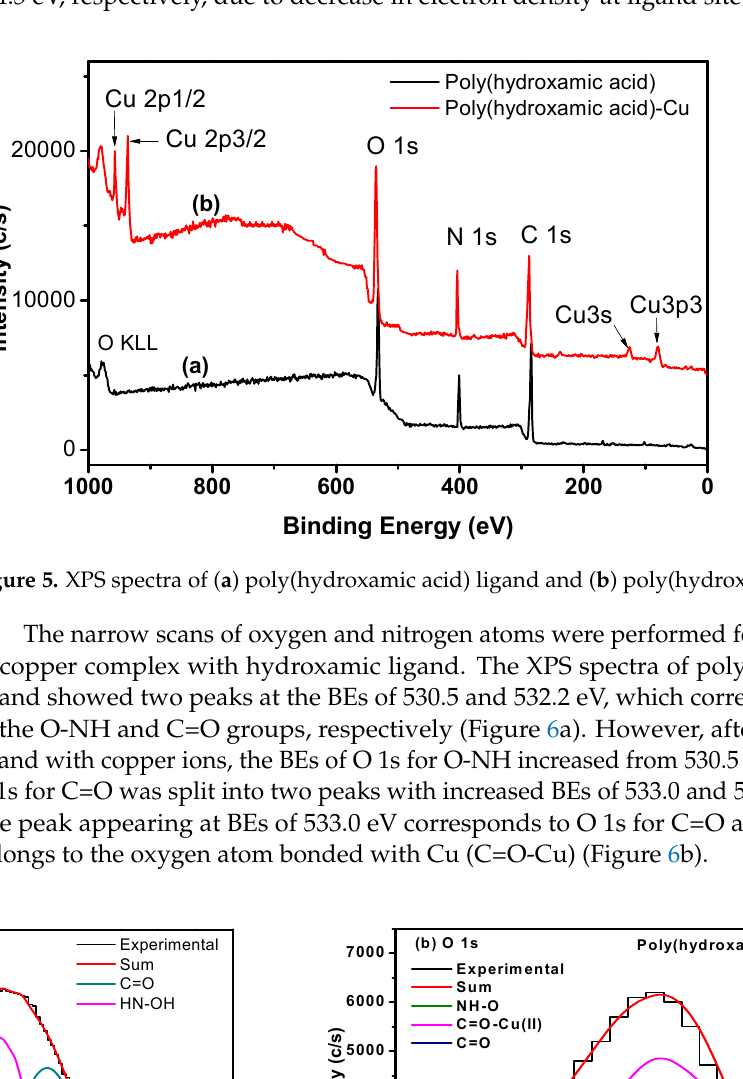
Figure 6. O1s core-level XPS spectra of ( a ) poly(hydroxamic acid) ligand and ( b ) poly(hydroxamic acid)-Cu(II) complex.